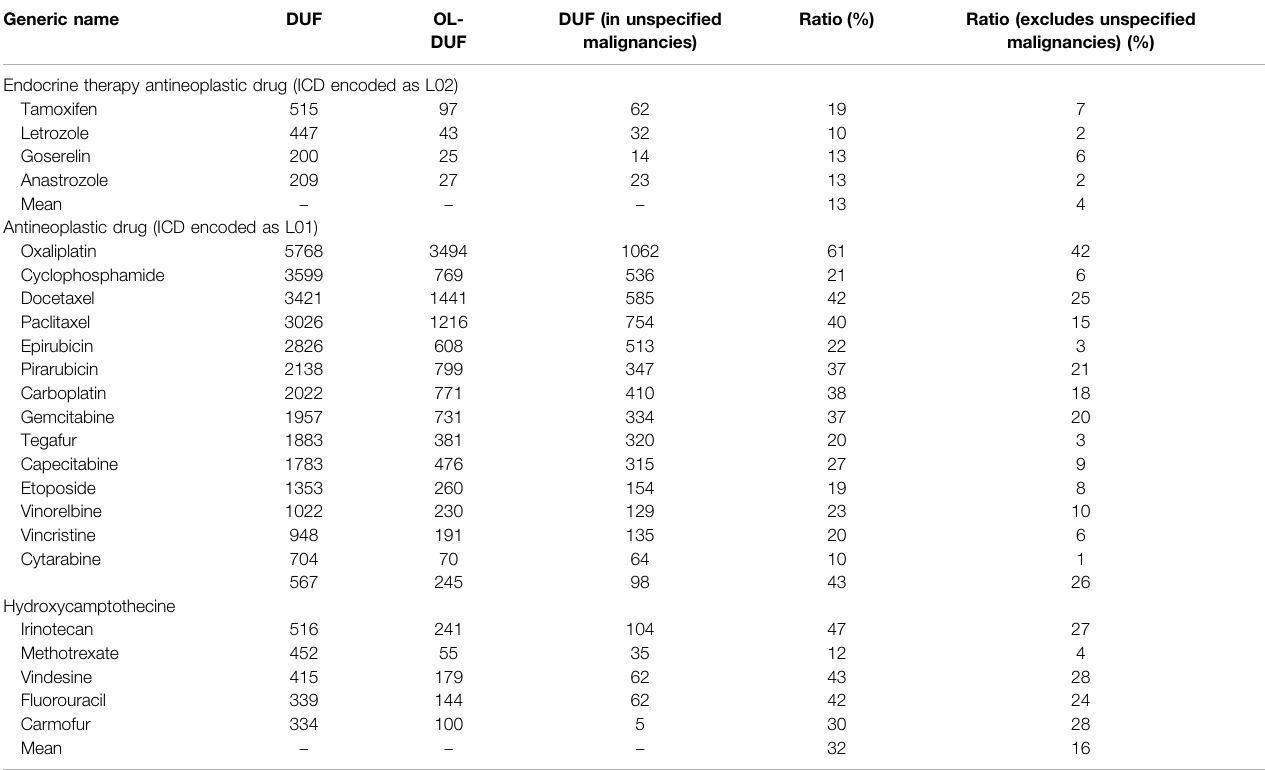
DUF,drugusefrequency;OL-DUF,off-labeldrugusefrequency;DUF(inunspeci fi edmalignancies),drugusefrequencyforunspeci fi edmalignancies;Ratio,theratioofoff-labeldruguse frequencytototalantineoplasticdrugusefrequency;Ratio(excludeunspeci fi edmalignancies),theratioofoff-labeldrugusefrequencytoantineoplasticdrugusefrequency,excludinguse for unspeci fi ed